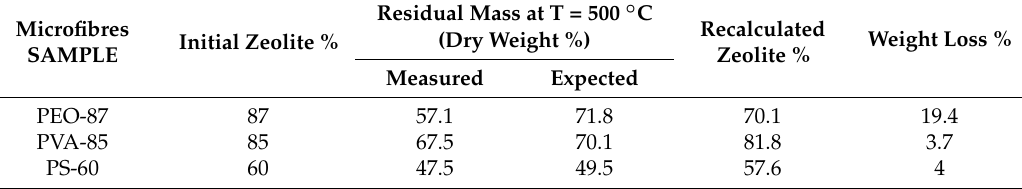
Table 2. Calculated zeolite composition of microfibres from residual mass at 500 ◦